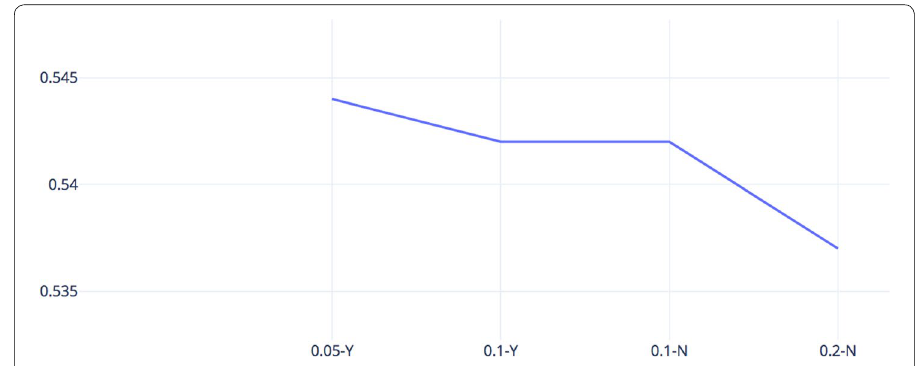
Fig. 6 Comparison of various NB and DF